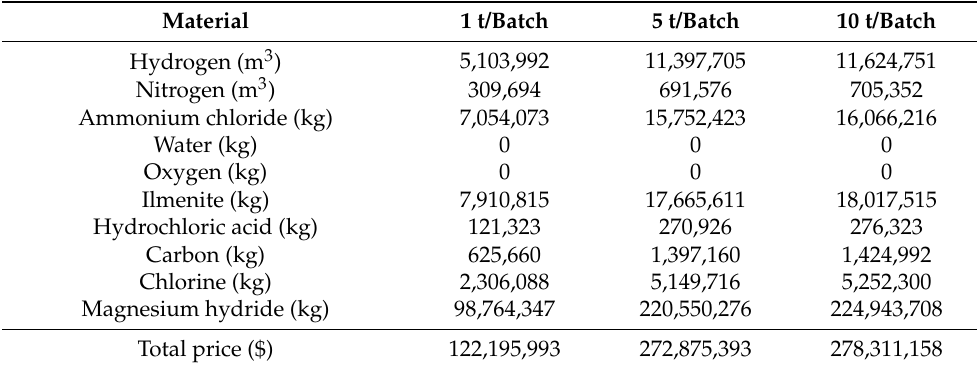
Table A5. Annual materials cost for different production scale of Ti powder.